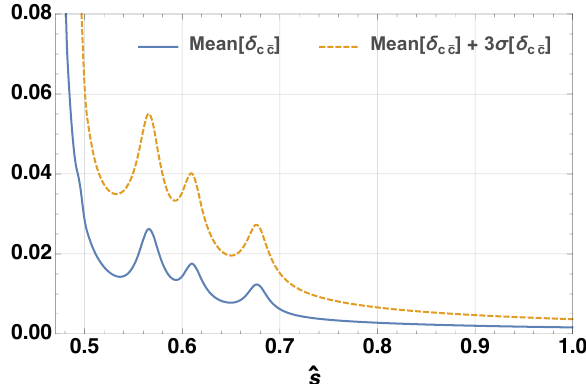
Figure 8 . Blue solid line: mean of | δ c ¯ c | /C 9 , SD as a function of ˆ s , obtained from a uniform scan to | η V | ∈ [1 , 3] and δ V ∈ [0 , 2 π ) . Dashed orange line: mean plus 3 times the standard